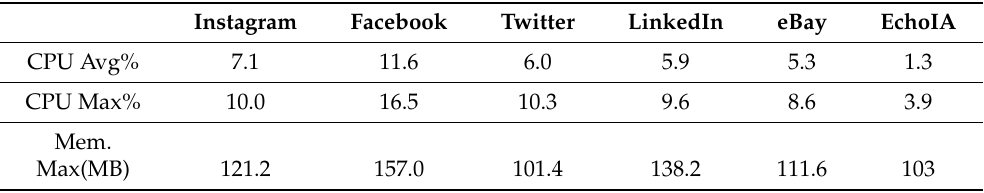
Table 1. CPU and memory